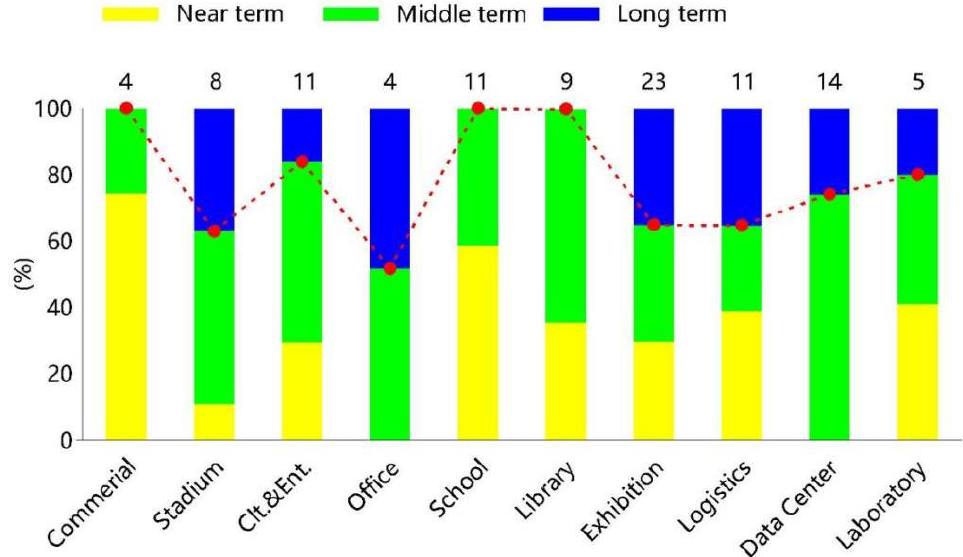
Figure 9. Renewal time distribution ratio of different replacement functions.